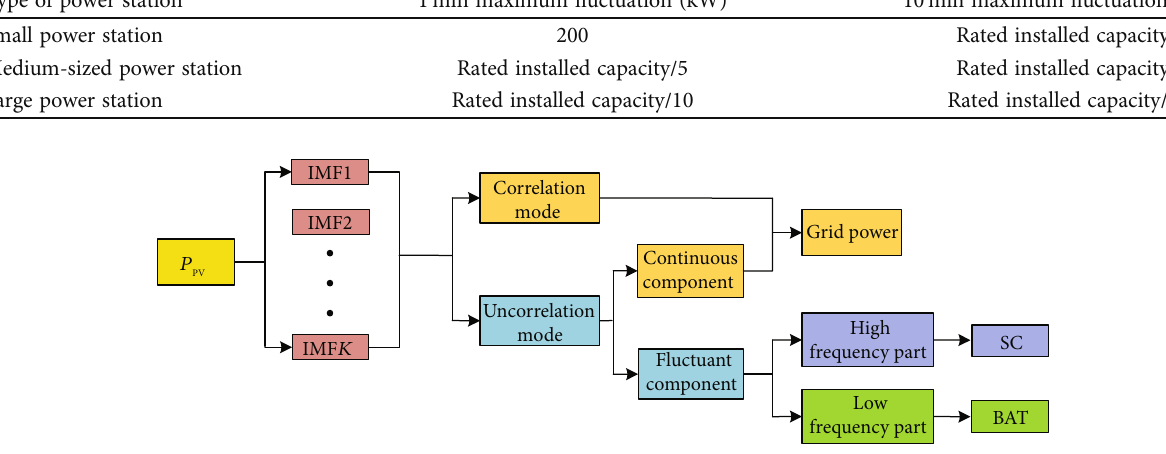
Figure 2: Hybrid energy storage power allocation